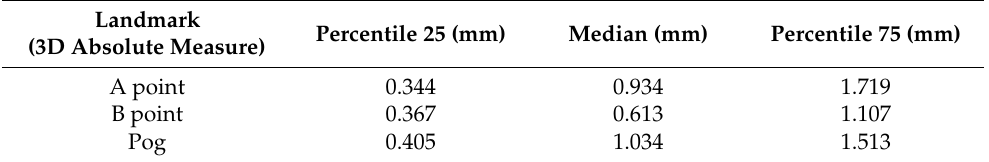
Table 2. Median and 25th and 75th percentiles of 3D absolute differences at landmarks point A, point B, and Pog.